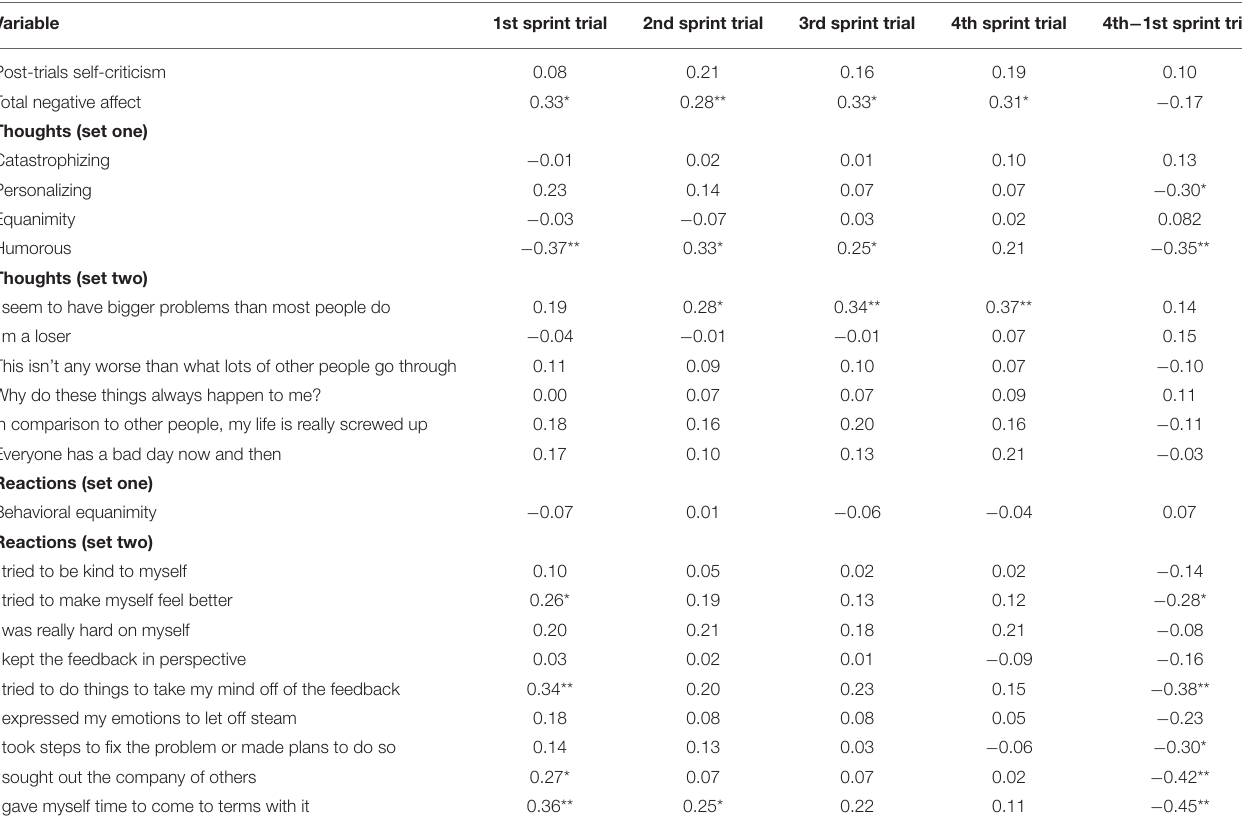
TABLE 6 | One-tailed Pearson correlations after receiving feedback after each sprint trial for Phase II participants.